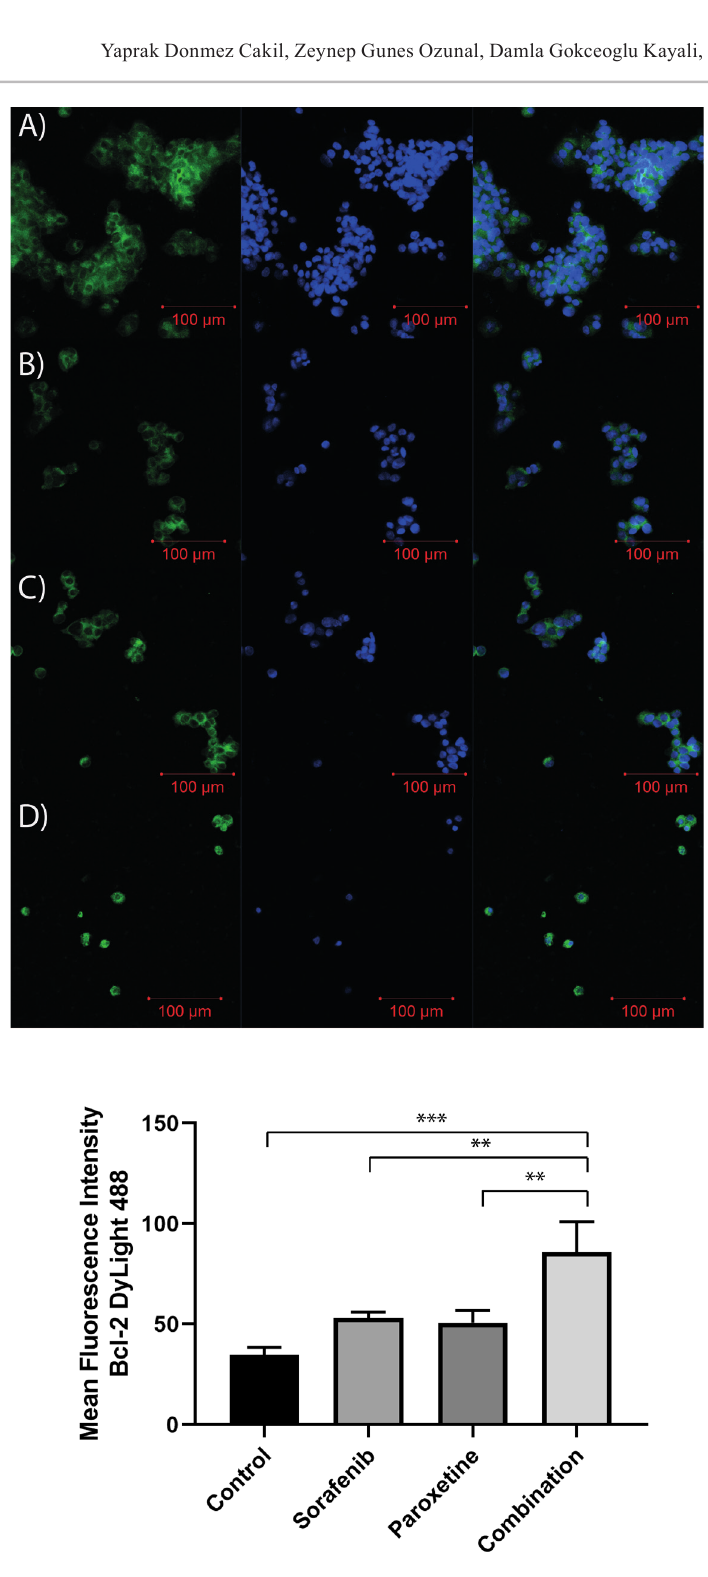
FIGURE 4 - Immunofluorescence detection of anti-apoptotic Bcl-2 in cells without any treatment (A), sorafenib treated (B), paroxetine treated (C), and co-treated with both drugs (D). After 24 h of incubation, the cells were labeled with the Bcl-2 antibody. IgG DyLight®488 was used as the secondary antibody. The nuclei were counterstained with Hoechst 33258. Bcl-2 fluorescence intensity was plotted (E). One-way ANOVA showed a significant difference among the groups (F[3,8 = 18.22]) **Significant difference in comparison to the sorafenib or paroxetine treated cells at P < 0.01. ***Significant difference in comparison to the control group at P <